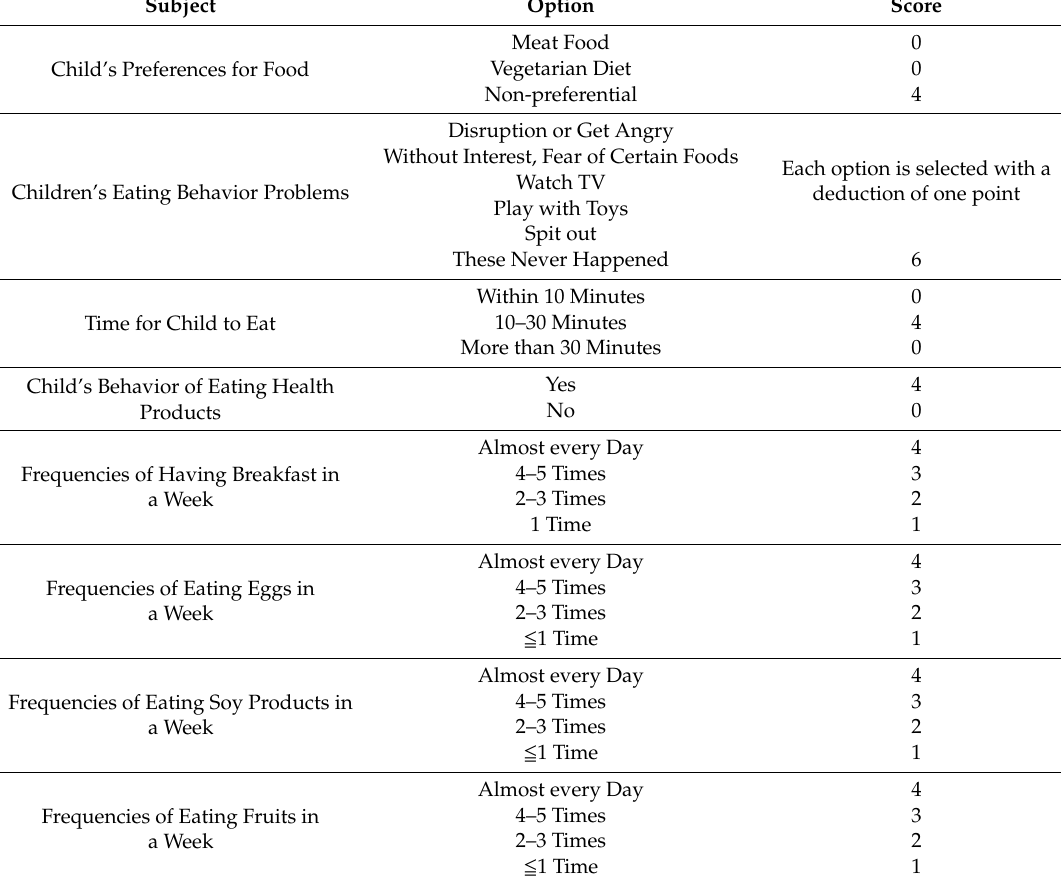
Table 5. Children’s eating behavior